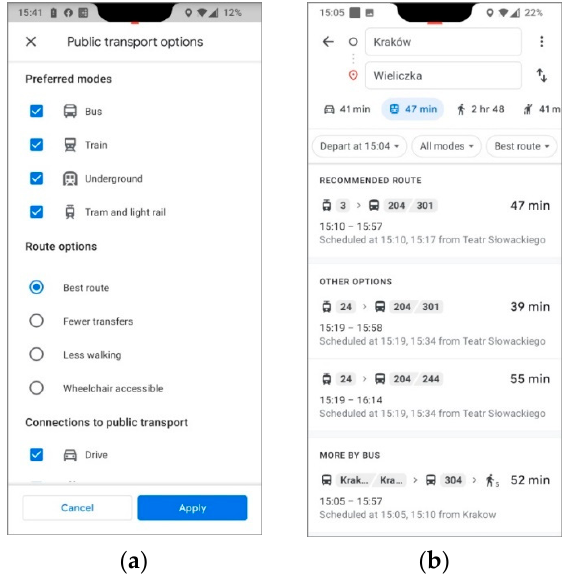
Figure 2. Overview of selected Google Transit tabs: ( a ) public transport options, route options; preferred modes; ( b ) the tab with information about possible connections between the defined